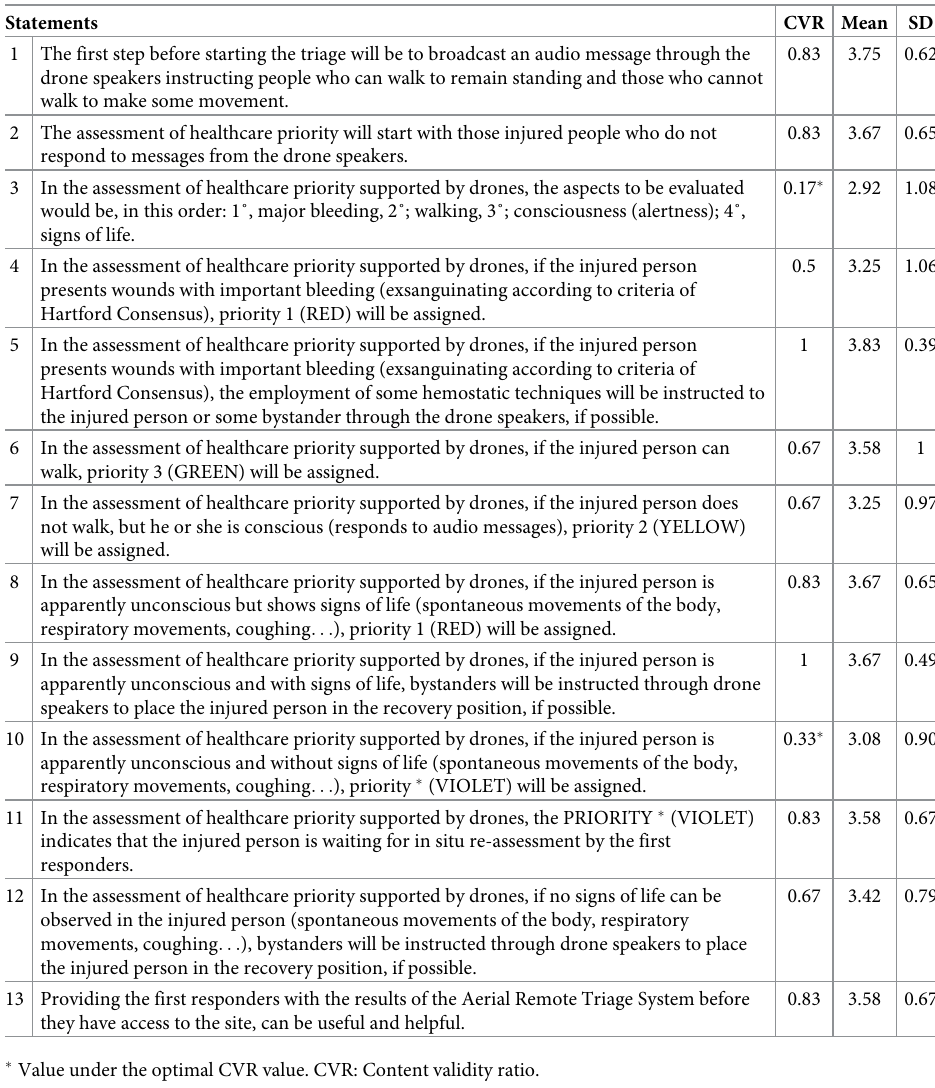
Table 3. Content evaluation of statements about triage with ARTS